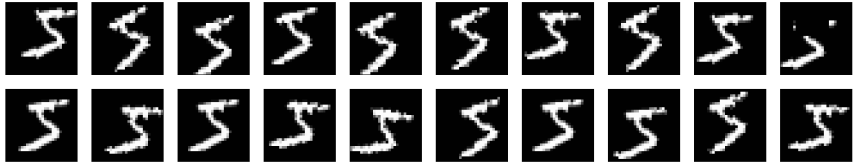
Figure 2. Random translation, random rotation and random erasing applied to a sample in the training